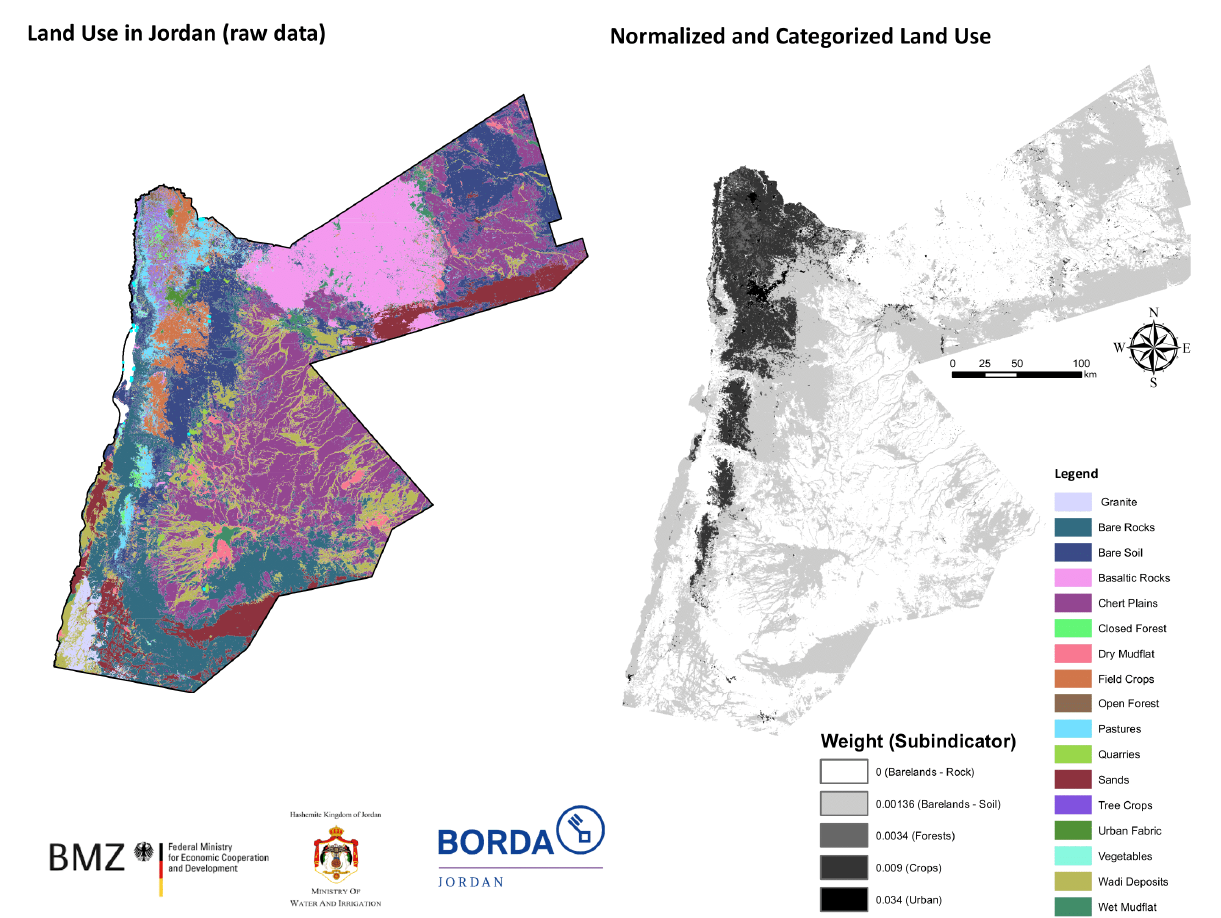
Figure 9. Land Use Indicator.